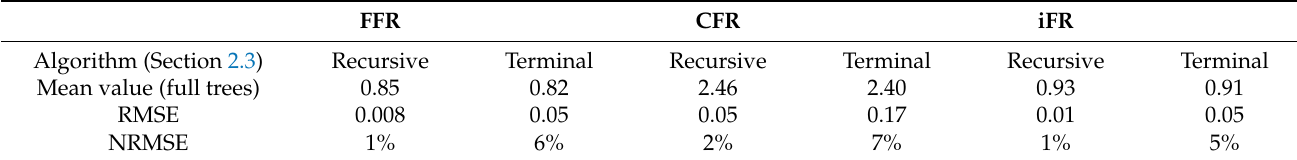
Table 2. Sensitivity of FFR, CFR, iFR to coronary tree detalization for two cases: (1) resistances distributed with recursive algorithm, (2) resistances distributed with terminal points algorithm. RMSE—root-mean-square error, NRMSE—normalized root-mean-square error. RMSE and NRMSE are calculated between indices (FFR, CFR, iFR) calculated on full trees and reduced